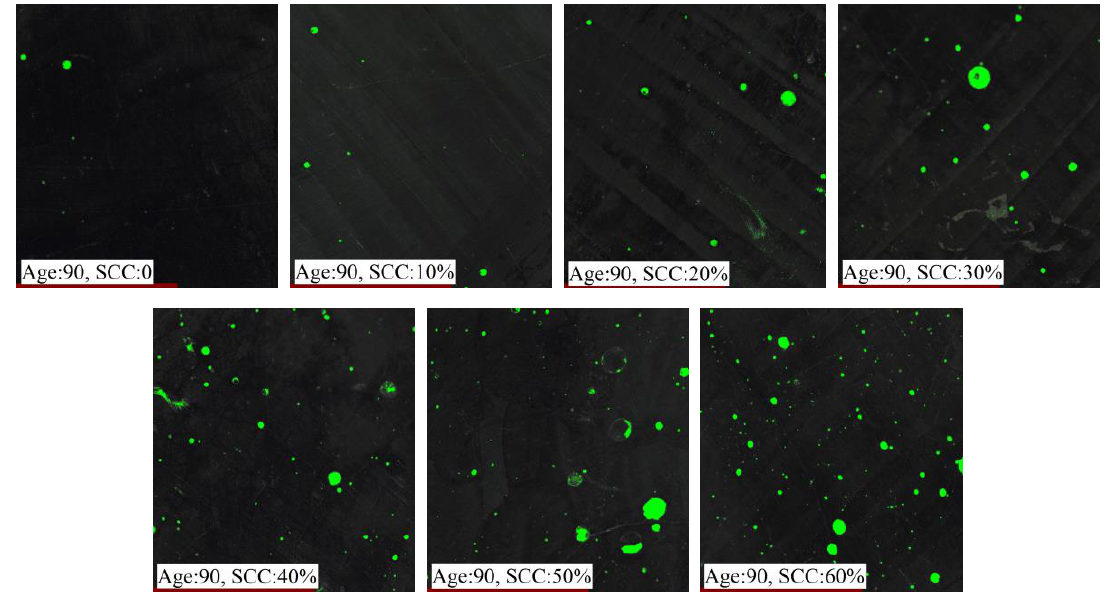
Figure 6. Pore structure distribution.